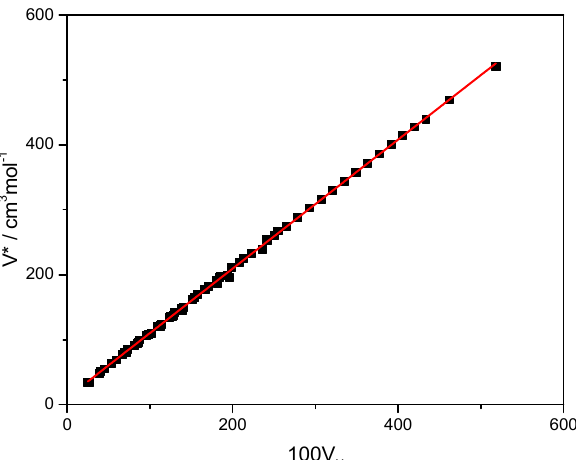
Figure 1. The hard core molar volumes of the LFHB model as a function of the corresponding McGowan volumes [16]. The straight line through the data obeys the equation V * = 11.357 + 99.49V x with R 2 = 0.9991; standard errors: 0.4963 (intercept), 0.0023 (slope).